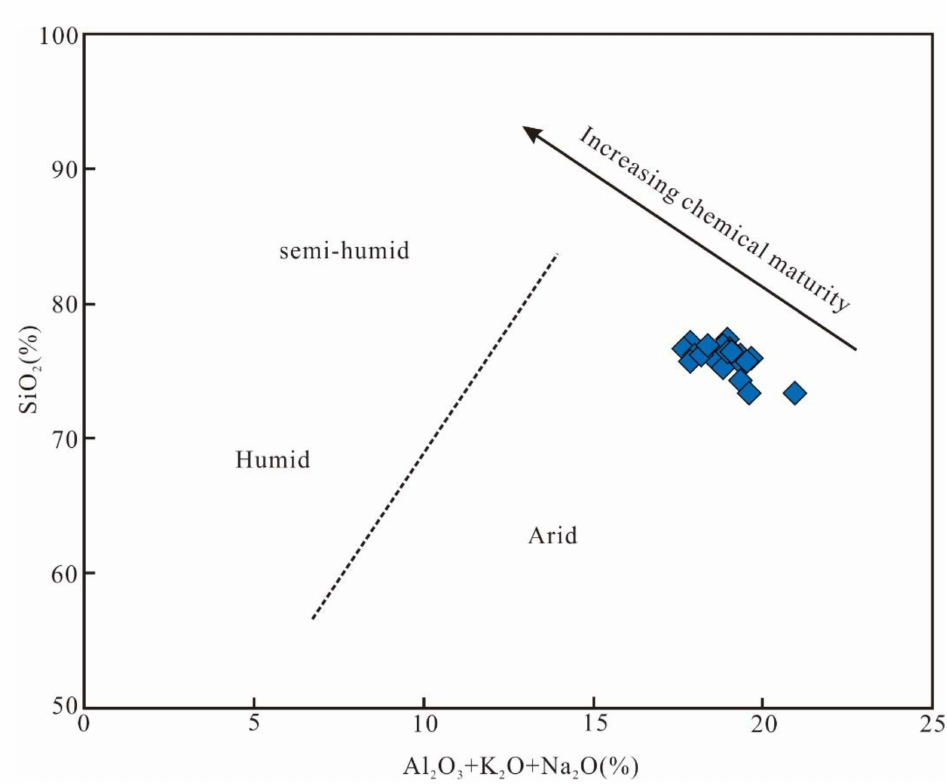
Figure 17. SiO 2 % versus Al 2 O 3 + K 2 O + Na 2 O% bivariate diagram for distinguishing climatic conditions of the Zhiluo Formation sandstones